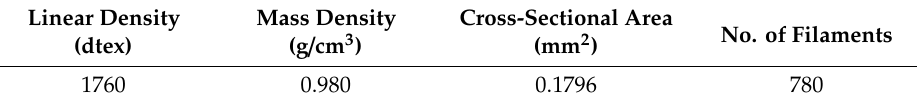
Table 1. Yarn properties as provided by the